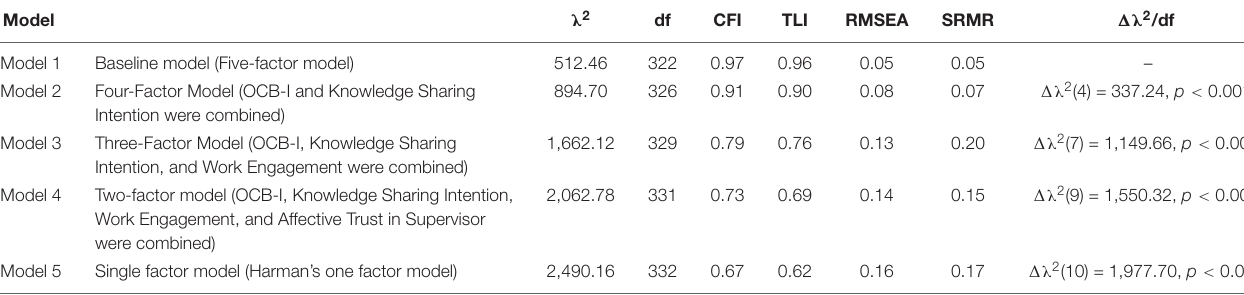
TABLE 3 | Demographic statistics and correlations between